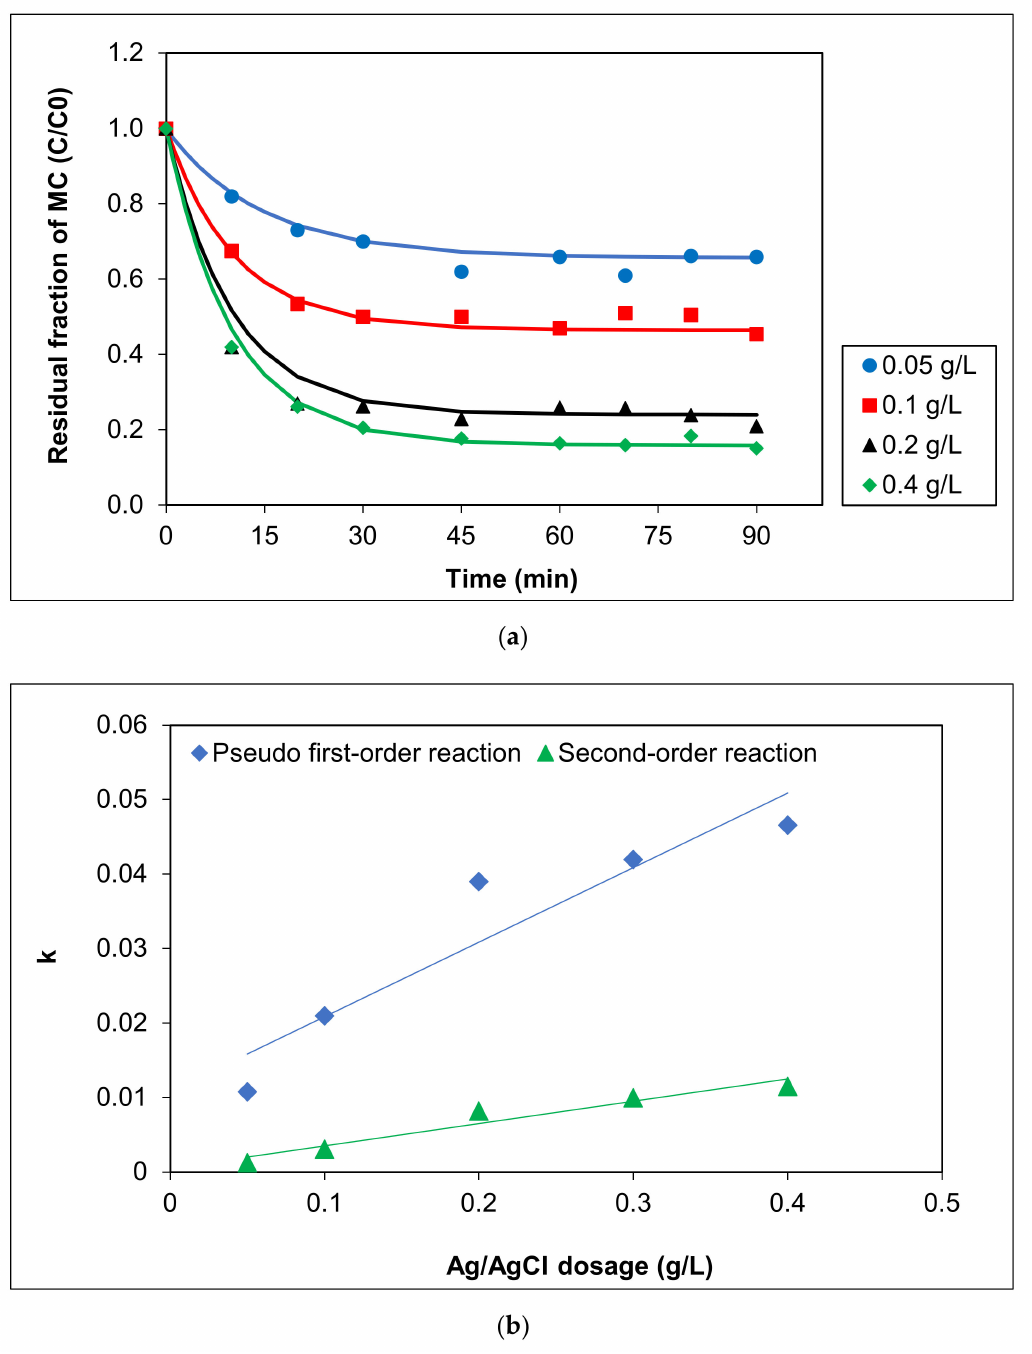
Figure 3. Effect of Ag/AgCl-G dosages on ( a ) residual fraction of MC with time using Ag/AgCl-G and ( b ) relation of kinetic constants (k) with Ag/AgCl dosage (pH = 10 and MC concentration = 10 mg L − 1